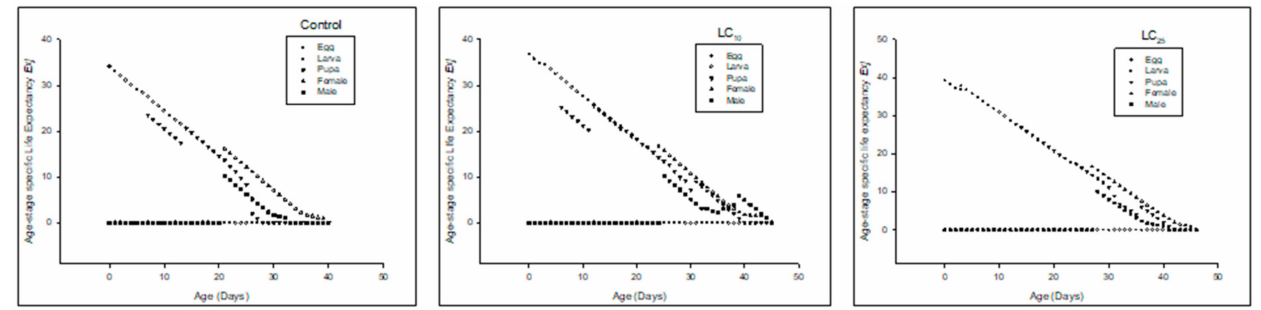
Figure 5. Age stage life expectancy ( e xj ) of the F 1 generation in Spodoptera frugiperda . The v xj of the F 1 generation denoted that the overall reproductive rate was reduced in LC25-treated insects, and LC 10 -treated insects had less reproductive rate as compared to the control (Figure